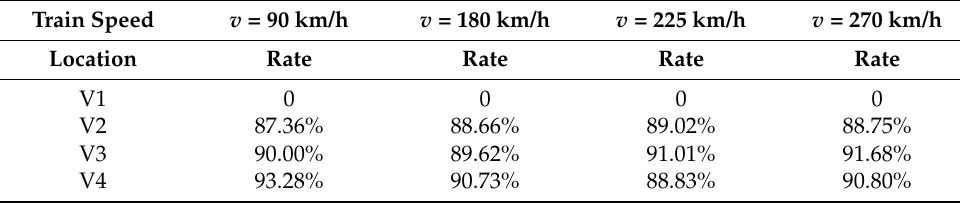
Table 7. Vibration velocity attenuation rate in the horizontal direction.